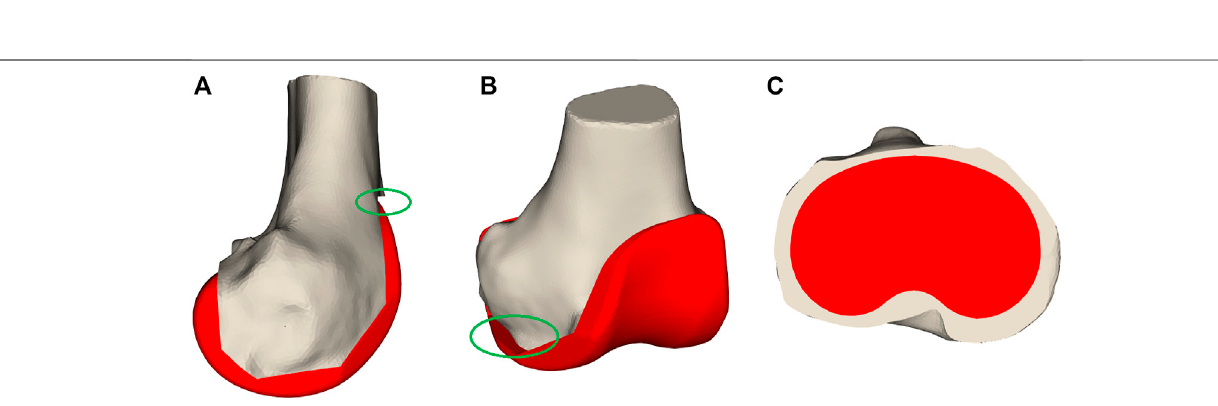
FIGURE 3 | (A) Femur and tibia with the landmark points annotated as spheres indicating prominent structures on the bones. Panels (B,C) show the femoral and tibial coordinate system, respectively.